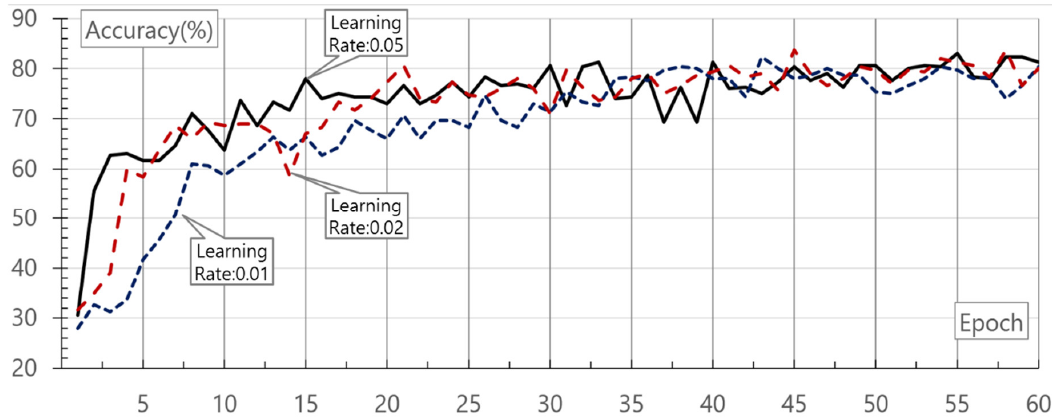
Figure 8. Result of accuracy evaluation according to learning rate and epoch of deep neural networks.